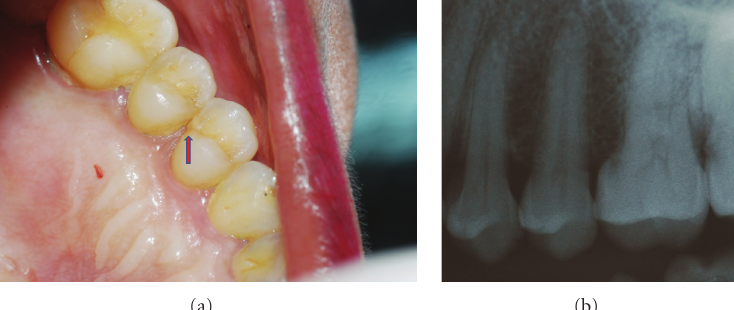
Figure 3: (a) Faint fracture line can be detected on distal marginal ridge extending onto proximal surface of 24. (b) Intraoral periapical radiograph of 24 reveals no significant findings.